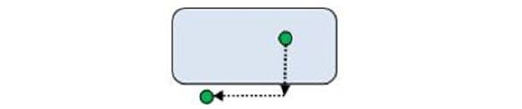
Figure 8. Jason’s second trip diagram.